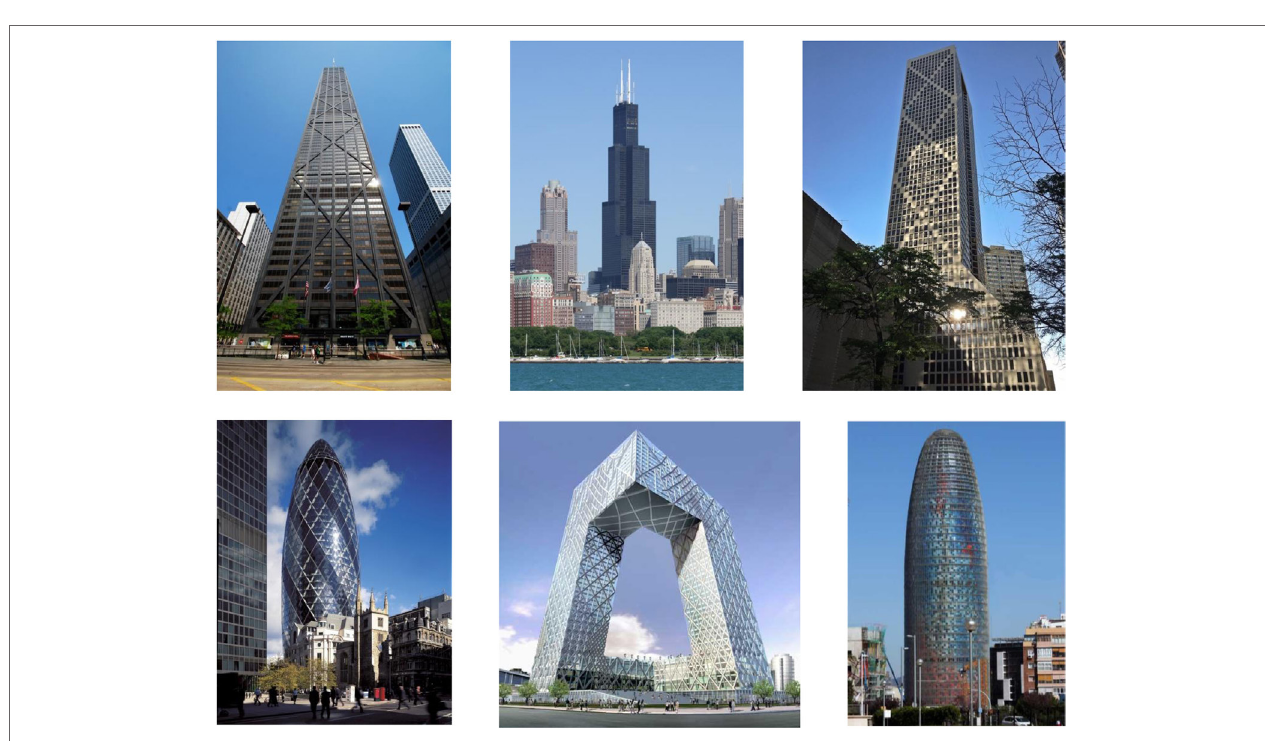
FigURe 5 | From the top left, clockwise: John Hancock Building (courtesy of Royce Douglas); Sears Tower (courtesy of Michiel Van Dijk); Onterie Center (courtesy of Marshall Gerometta); Agbar Tower, Barcelona (courtesy of Mary Ann Sullivan); CCTV, Beijing (courtesy of Office for Metropolitan Architecture); and 30 St. Mary’s Axe, London (courtesy of Nigel Young).